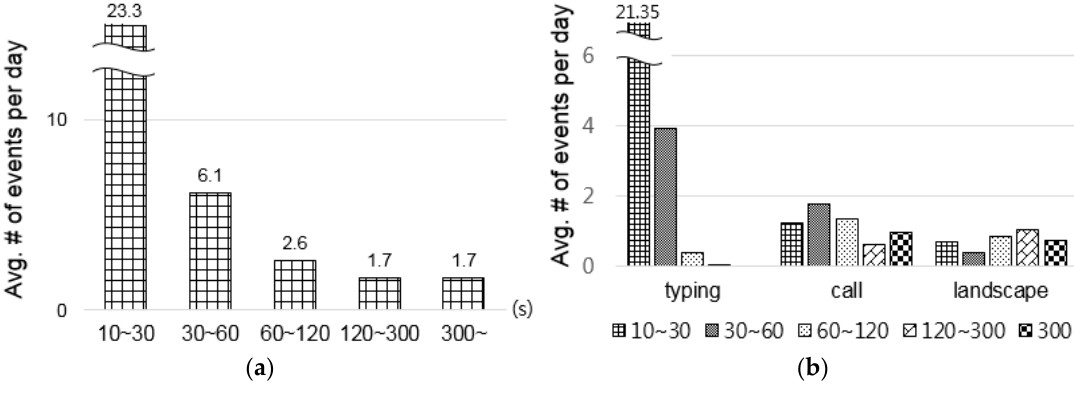
Figure 1. Average number of potential opportunities: ( a ) Different time durations; ( b ) different use cases.